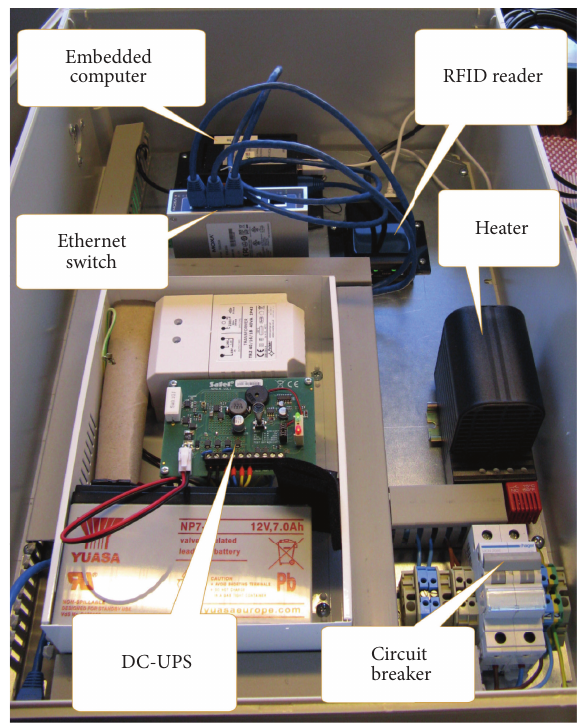
Figure 8: A new type of LAN-reader with SD card and integrated